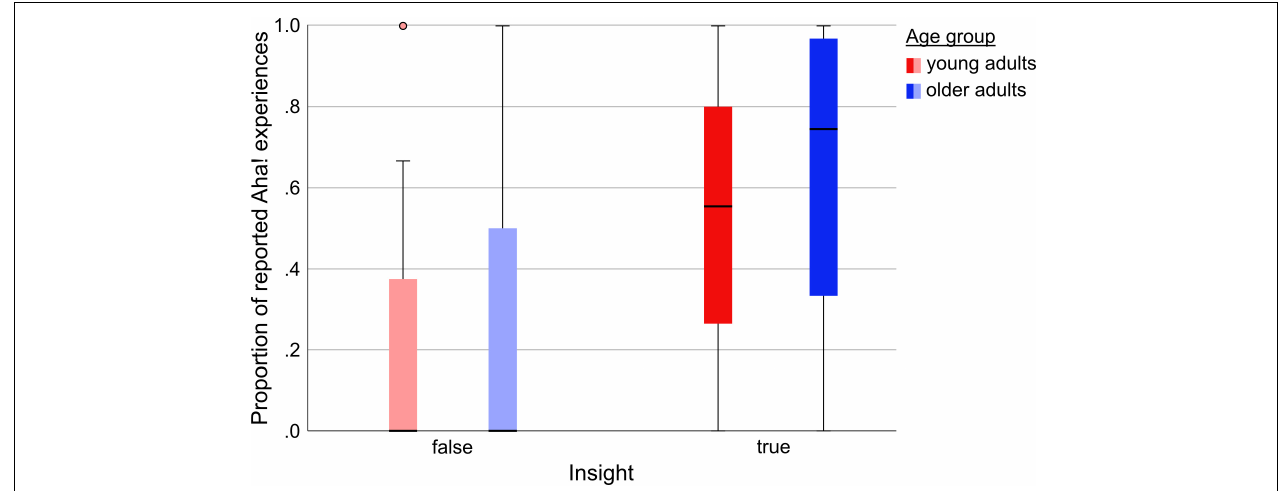
FIGURE 6 | Proportion of reported Aha! experiences for correctly (true insight) and incorrectly (false insight) solved items by Age group (young, older).